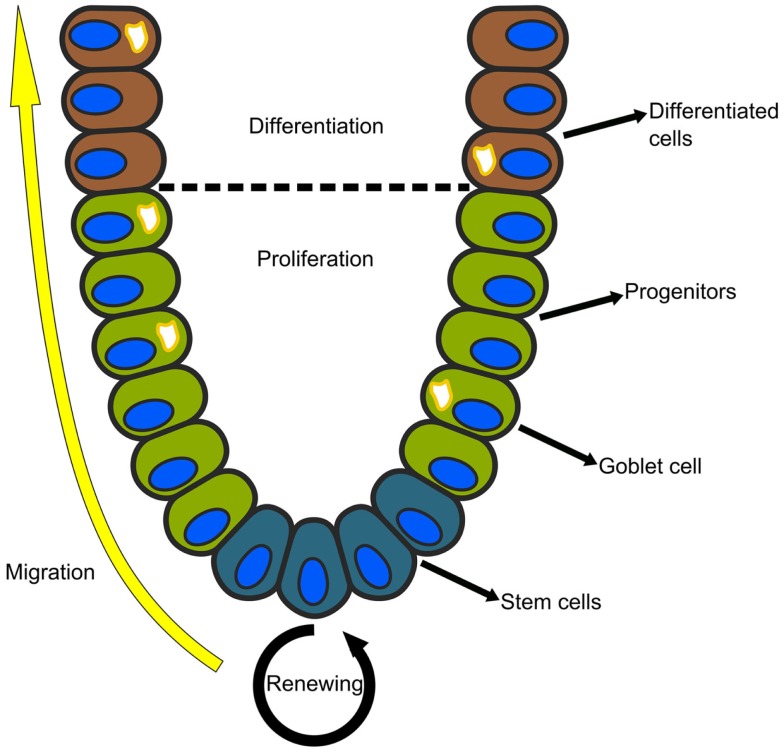
Each crypt in the mammalian small intestine or colon is an independently regenerating unit. The stem cells reside at the bottom and their progeny migrate upwards as they proliferate and differentiate. In the colon, there are two main cell lineages: absorptive enterocytes and secretory goblet cells.